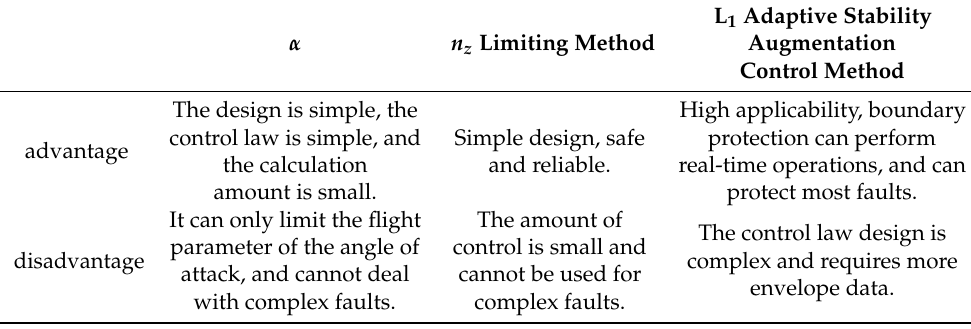
Table 2. Advantages and disadvantages of various protection